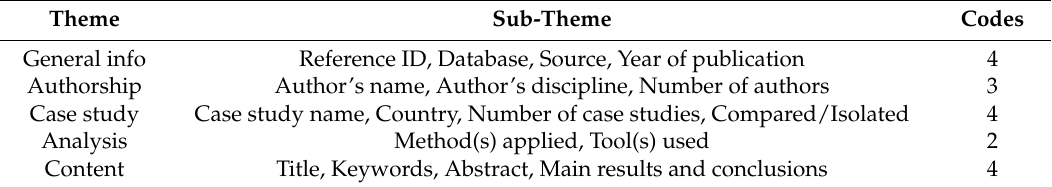
Table 3. Code book including main themes and sub-themes used for the content